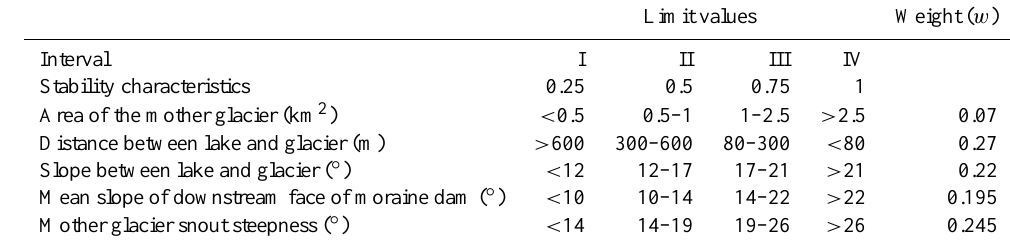
Table 7. The assessed stability characteristics, their weighting, and threshold values defined by Wang et al. (2011).